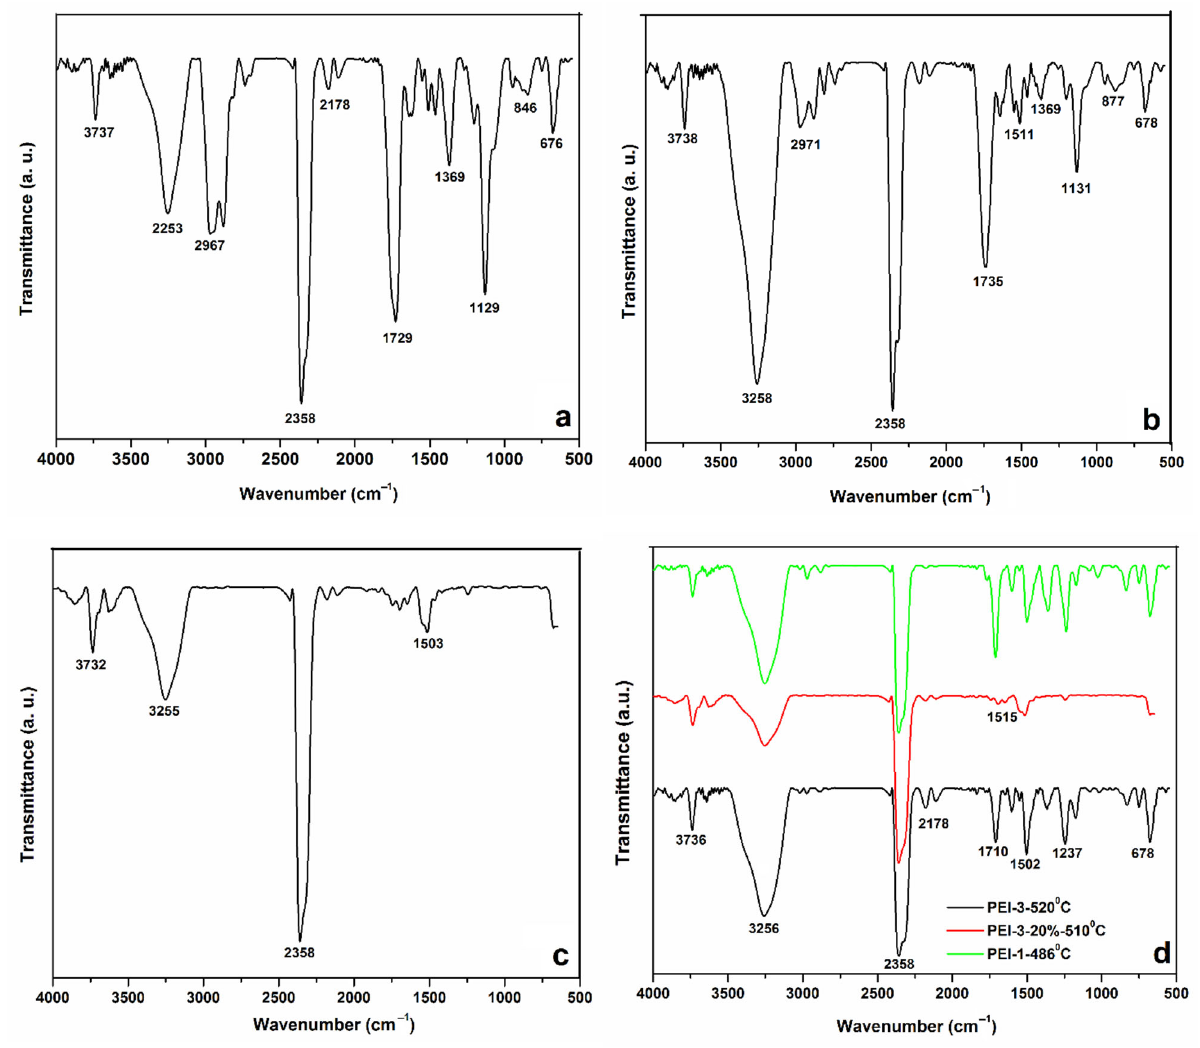
Figure 8. FTIR spectra for PEI-1 at 426 ◦ C ( a ), PEI-3 at 427 ◦ C ( b ), and PEI-3-20% at 429 ◦ C ( c ), and these samples at higher temperatures for thermal decomposition in nitrogen ( d ).